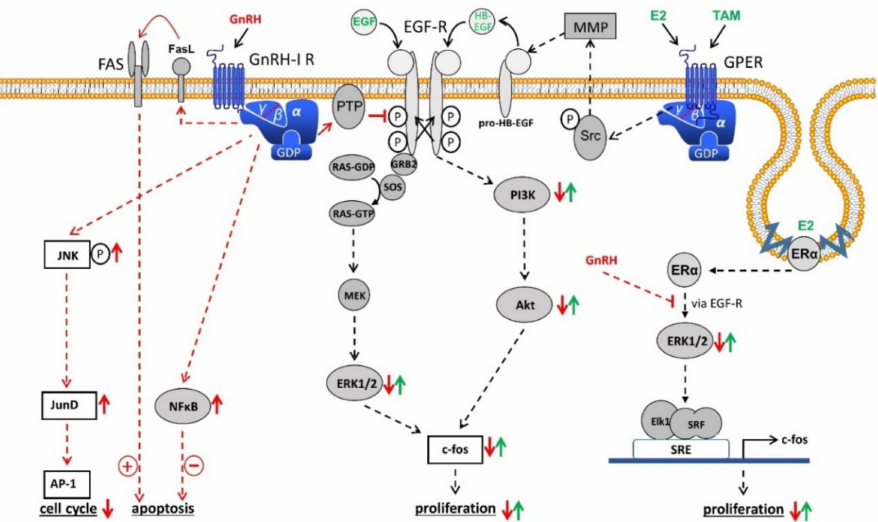
Figure 1. Schematic representation of GnRH-I receptor signaling in ovarian cancer cells. Binding of GnRH-I and GnRH-I analogs causes G-protein α i-mediated activation of a PTP, resulting in dephosphorylated EGF-R and inhibition of EGF-R signaling through ERK1/2 or PI3K/AKT pathway leading to reduction of proliferation. GnRH-I-induced activation of PTP also inhibits the signal transduction of GPER and membrane-associated ER α through transactivation of EGF-R. In addition, GnRH induces activation of NF κ B to reduce and FAS-ligand to increase apoptosis. Finally, GnRH agonists activate the JNK/AP-1 pathway resulting in increased G0/1 phase of the cell cycle and decreased synthesis of DNA. Further details are described in the text. Abbreviations: Akt, protein kinase B (PKB); AP-1, activator protein-1; E2, estradiol; EGF, epidermal growth factor; EGF-R, EGF receptor; ER α , estrogen receptor α ; ERK1/2, p44/42 mitogen-activated protein (MAP) kinase; FAS, Fas receptor; FasL, Fas ligand; GDP, guanosine diphosphate; GnRH, gonadotropin-releasing hormone; GPER, G-protein coupled estrogen receptor; GRB2, growth factor receptor-bound protein 2; GTP, guanosine triphosphate; HB-EGF, heparin-binding EGF-like growth factor; JNK, c-Jun N-terminal kinase; JunD, transcription factor JunD; MEK, mitogen-activated protein kinase kinase (MAP2K); MMP, matrix metalloproteinase; NFkB, nucleus factor kB; PI3K, phosphoinositide 3-kinase; PTP, protein tyrosine phosphatase; RAS, G-protein rat sarcoma; SOS, guanine nucleotide exchange factor “son of sevenless”; SRE, serum response element; Src, tyrosine kinase cellular sarcoma; SRF, serum response factor; TAM,